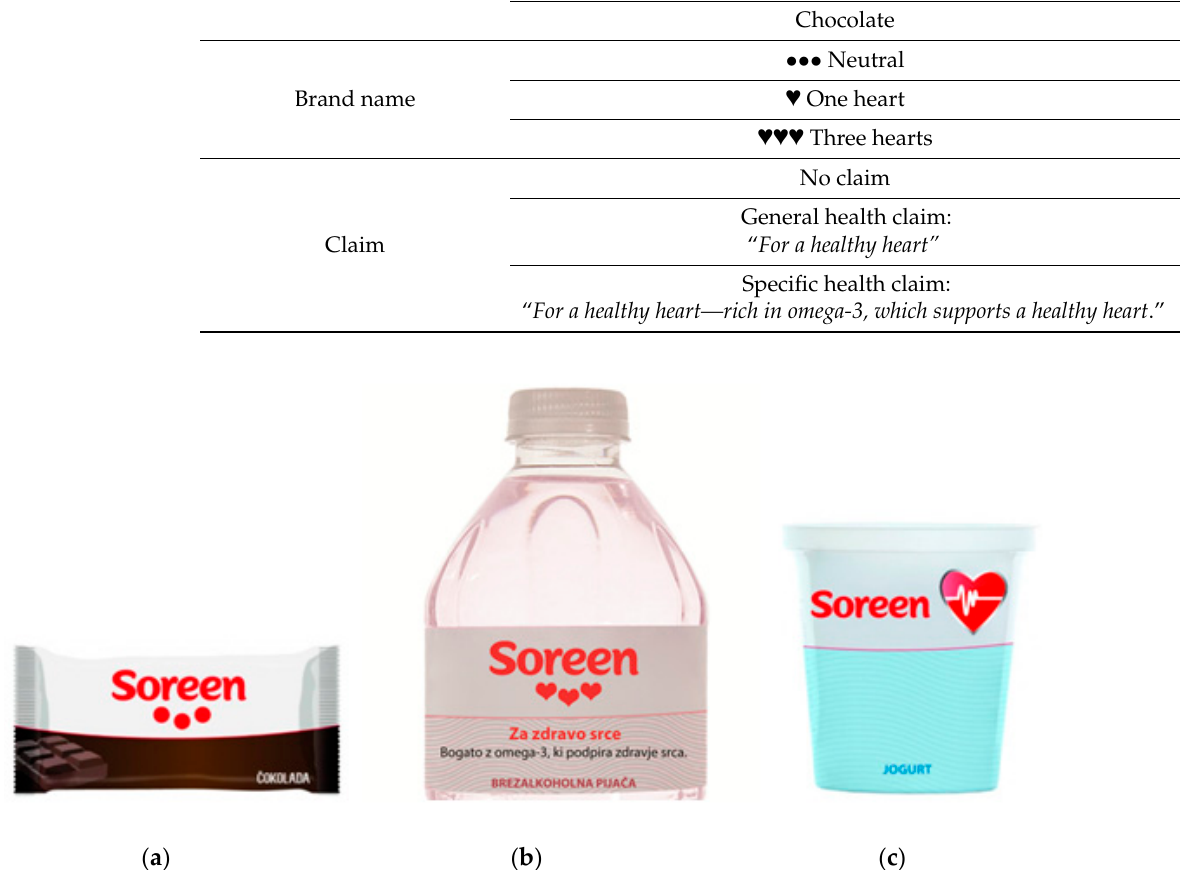
Figure 2. Examples of stimuli used in the conjoint analyses task: ( a ) Chocolate with a neutral brand ( ••• ); ( b ) soft drink with three hearts ( (cid:170)(cid:170)(cid:170) ); ( c ) yoghurt with health-implying heart image ( (cid:170)